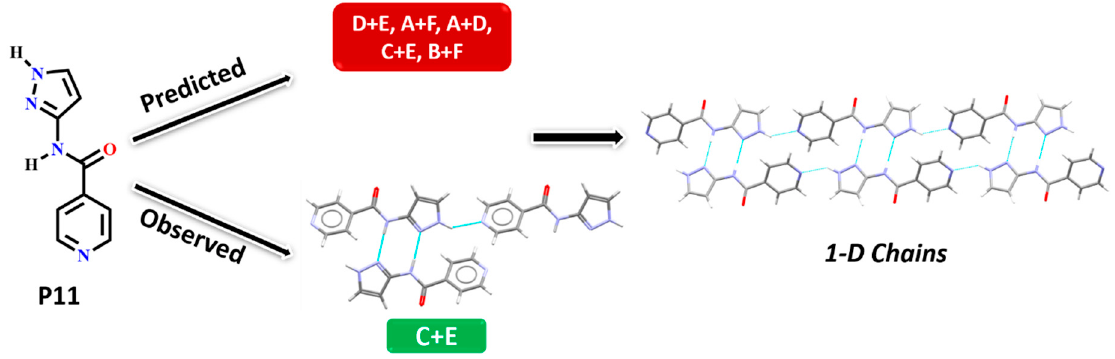
Figure 9. Synthon and packing observed in the crystal structure of P10 leading to herringbone-like structure.